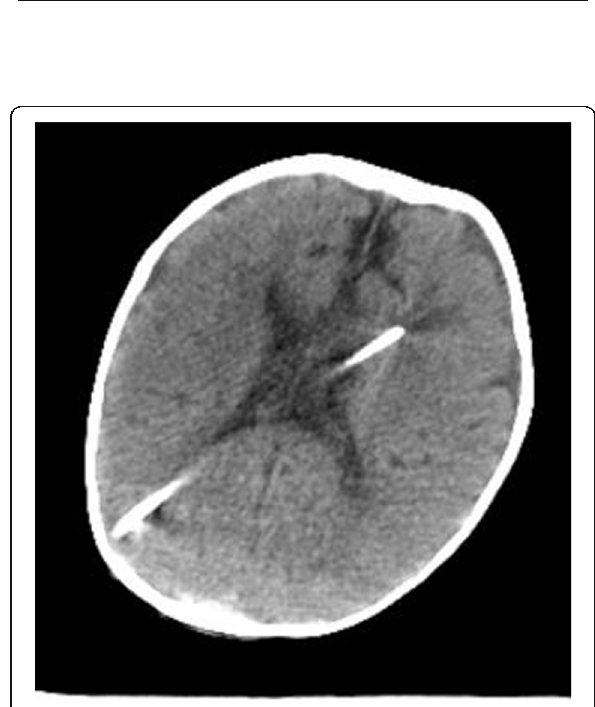
Fig. 2 CT scan of head showing decompressed ventricular system, with ventricular shunt catheter in